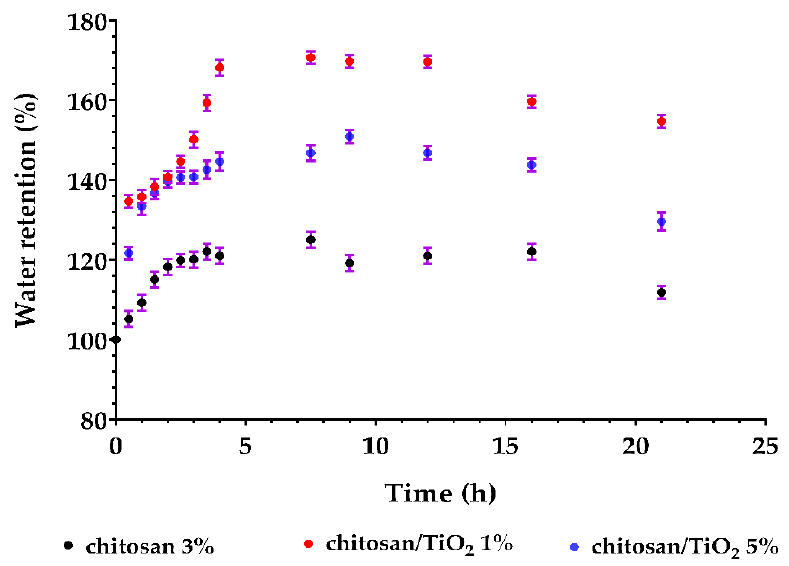
Figure 16. Swelling behavior for the chitosan and chitosan/TiO 2 composite membranes.